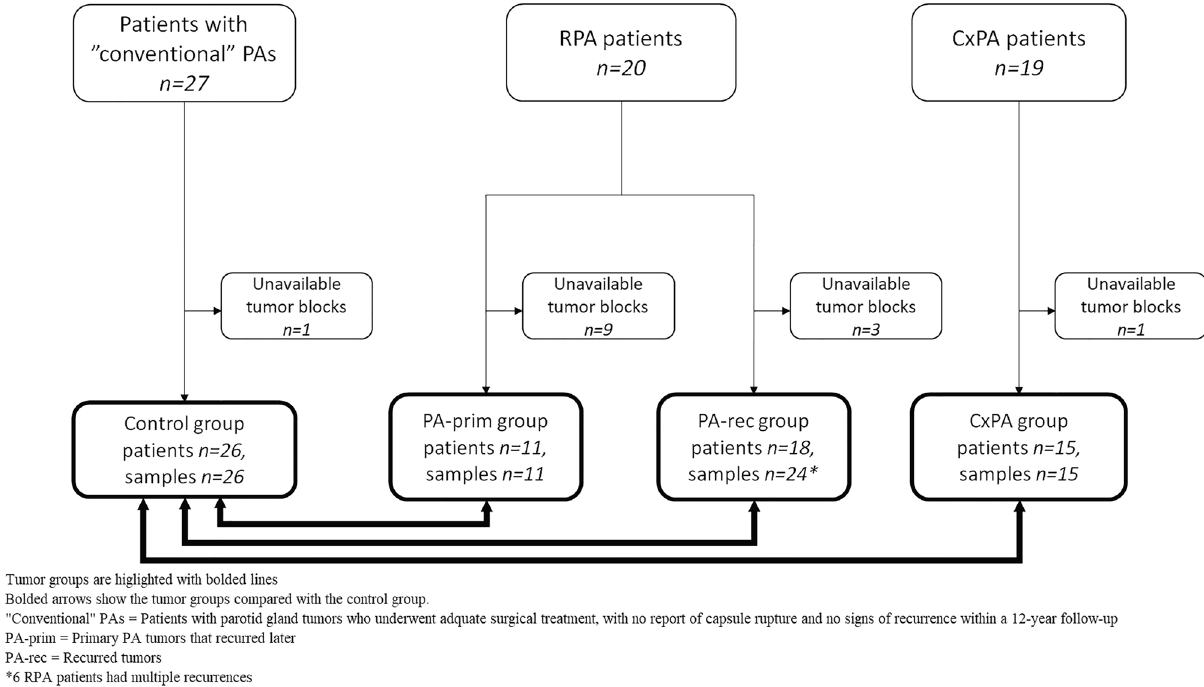
Figure 1. Flowchart illustrating the formation of the tumor